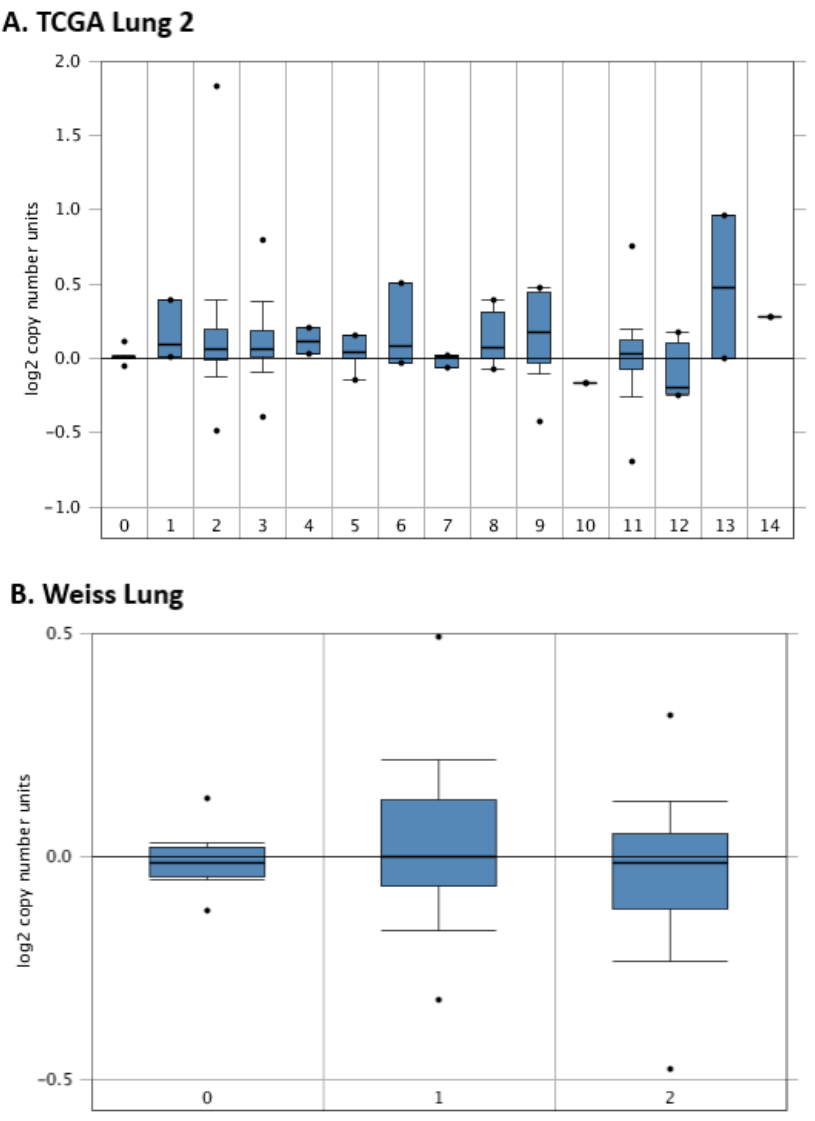
Figure 9. HMGA1 copy number in normal lung tissue and different histological subtypes of lung neoplasm by Oncomine: ( A ) TCGA lung 2: 0. normal lung ( n = 810), 1. acinar lung ( n = 6), 2. lung adenocarcinoma ( n = 261), 3. lung adenocarcinoma, mixed subtype ( n = 67), 4. lung clear cell adenocarcinoma ( n = 2), 5. lung mucinous adenocarcinoma ( n = 6), 6. micropapillary lung adenocarcinoma ( n = 3), 7. mucinous bronchioloalveolar carcinoma ( n = 3), 8. non-mucinous bronchioloalveolar carcinoma ( n = 9), 9. papillary lung adenocarcinoma ( n = 10), 10. solid lung adenocarcinoma ( n = 1), 11. squamous cell lung carcinoma ( n = 348), 12. squamous cell lung carcinoma, basaloid variant ( n = 8), 13. squamous cell lung carcinoma, papillary variant ( n = 2), 14. squamous cell lung carcinoma, small cell variant ( n = 1); ( B ) Weiss lung: 0. normal lung ( n = 59), 1. lung adenocarcinoma ( n = 77), 2. squamous cell lung carcinoma ( n = 155).